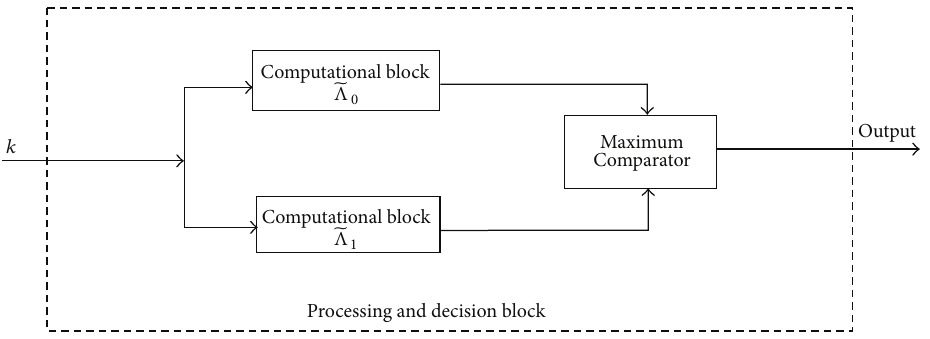
Figure 1: The block scheme of the processing and decision system.